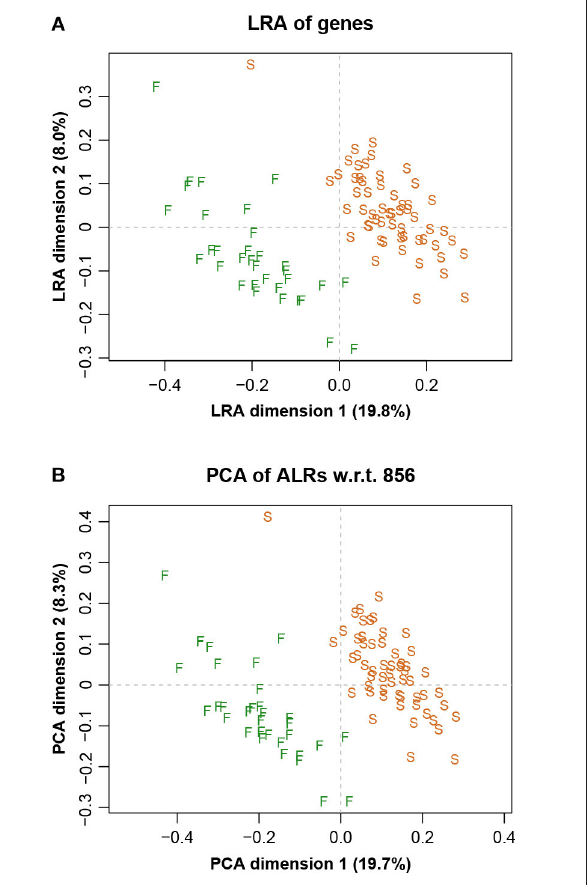
FIGURE 3 | (A) Logratio analysis of the Rabbits data, aiming to explain the total logratio variance. (B) Principal component analysis of the additive logratios with reference component microbial gene number 856, showing a geometry practically identical to the exact logratio geometry (Procrustes correlation 0.9991). The two groups of points are due to two sequencing = laboratories, indicated here by F and S.